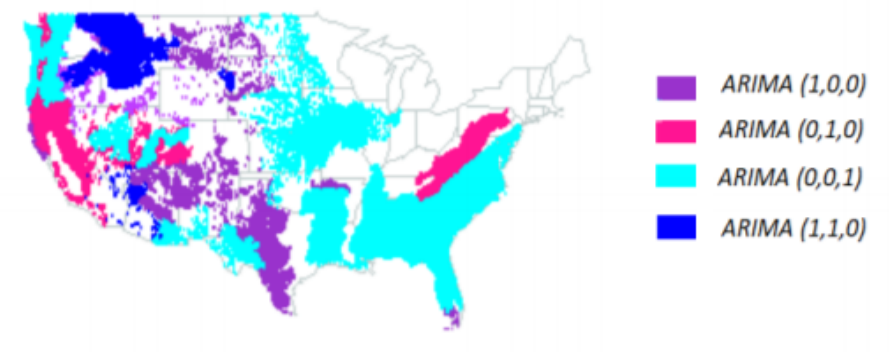
Figure 7. ARIMA models for the basal area yearly averages